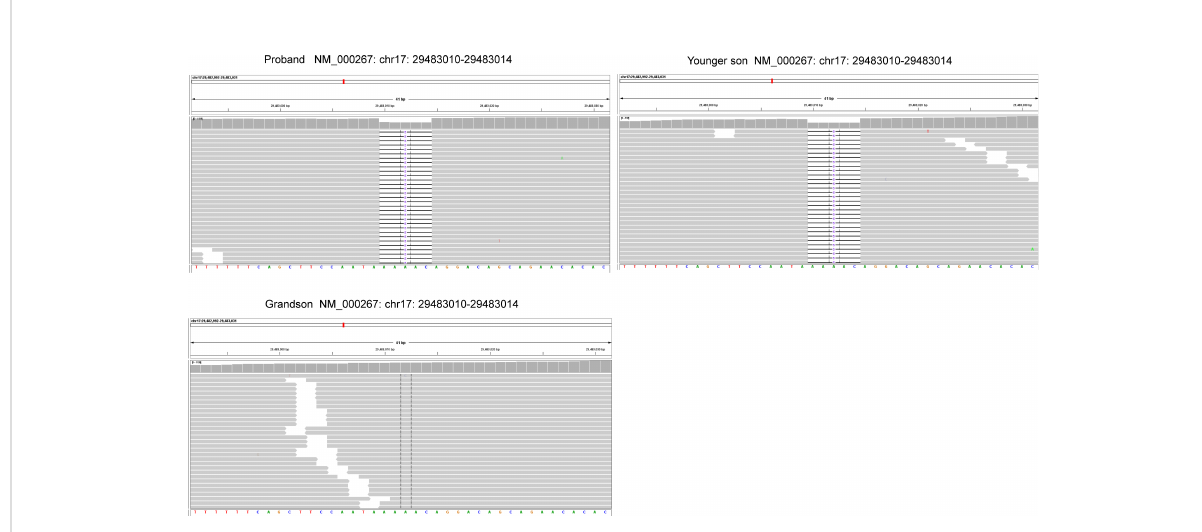
FIGURE 3 The Integrative Genome Viewer (IGV) snapshot of NF1.